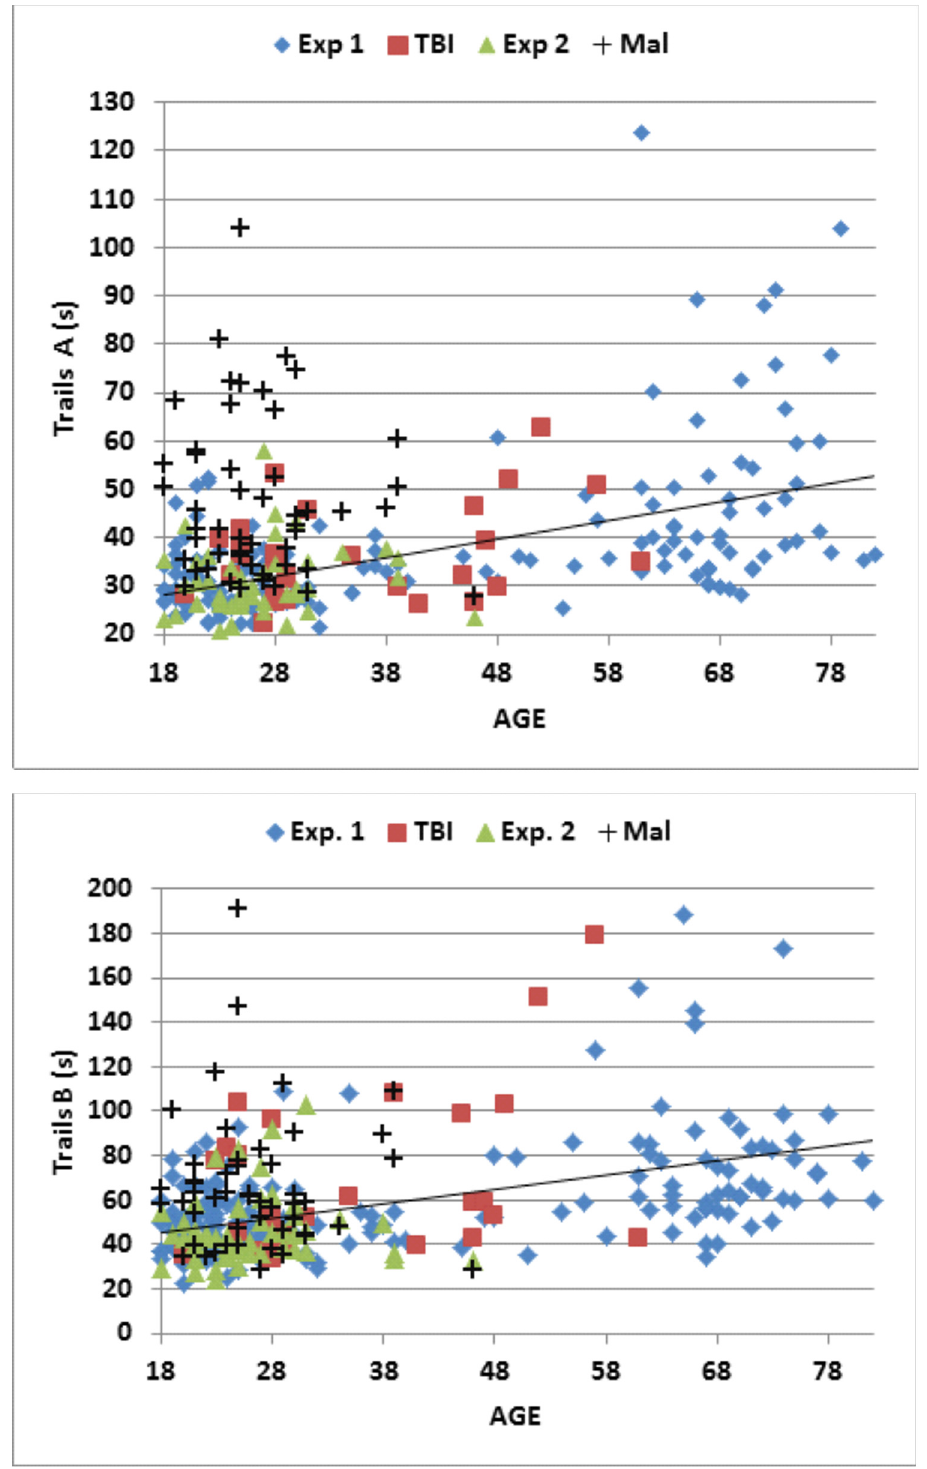
Fig 4. C-TMT completion times for Trails A (top) and Trails B (bottom). Shown as a function of age. The data are from Experiment 1 (blue diamonds), the first session of Experiment 2 (green triangles), malingering subjects in Experiment 3 (Mal, black crosses), and TBI patients in Experiment 4 (red squares). The linear age-regression functions from Experiment 1 are shown.